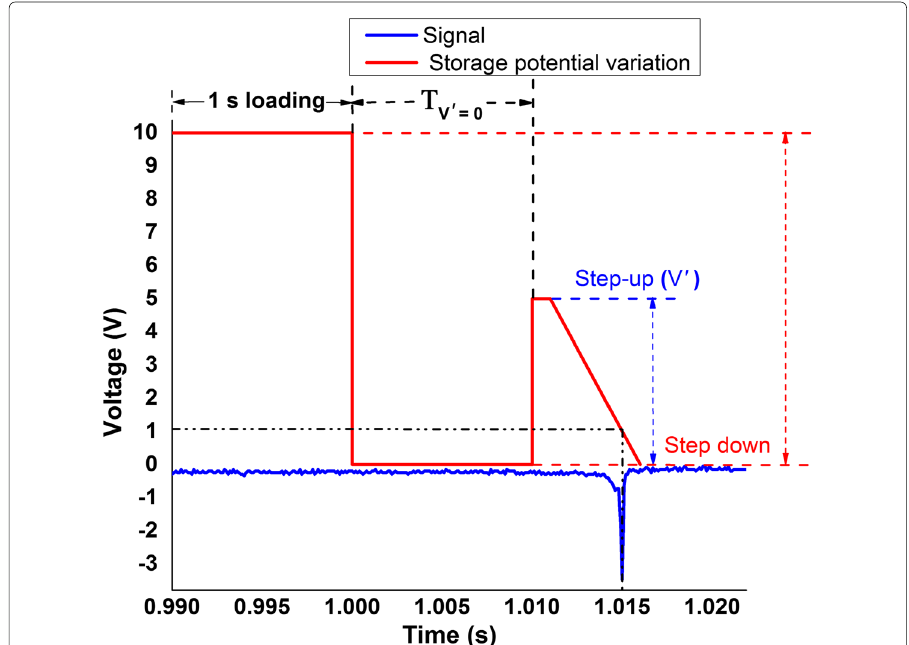
Fig. 6 Schematic diagrams showing electron signal along with variation of storage potential in different steps where, T V (cid:4) = 0 is the time for which the storage potential is zero